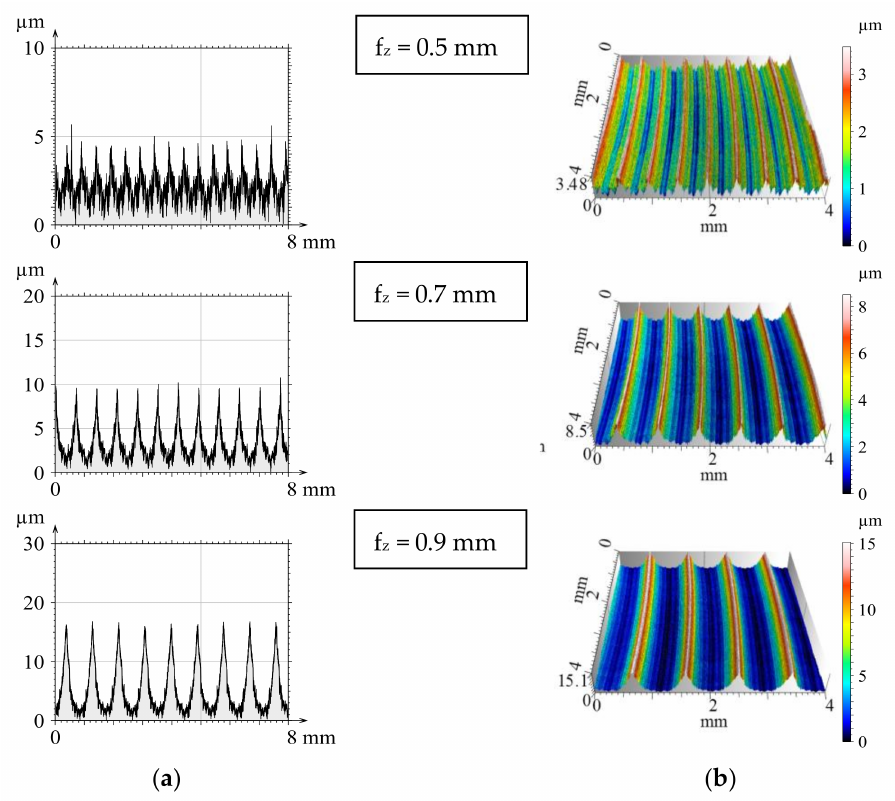
Figure 4. Roughness profiles ( a ) and topographic images ( b ) of face milling with one